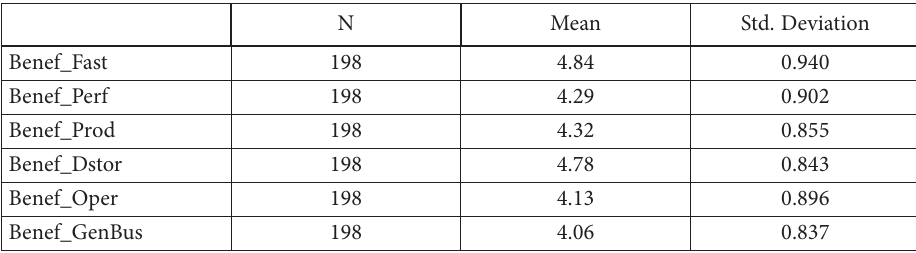
Table 7. Descriptive statistics for thevariable perceived business